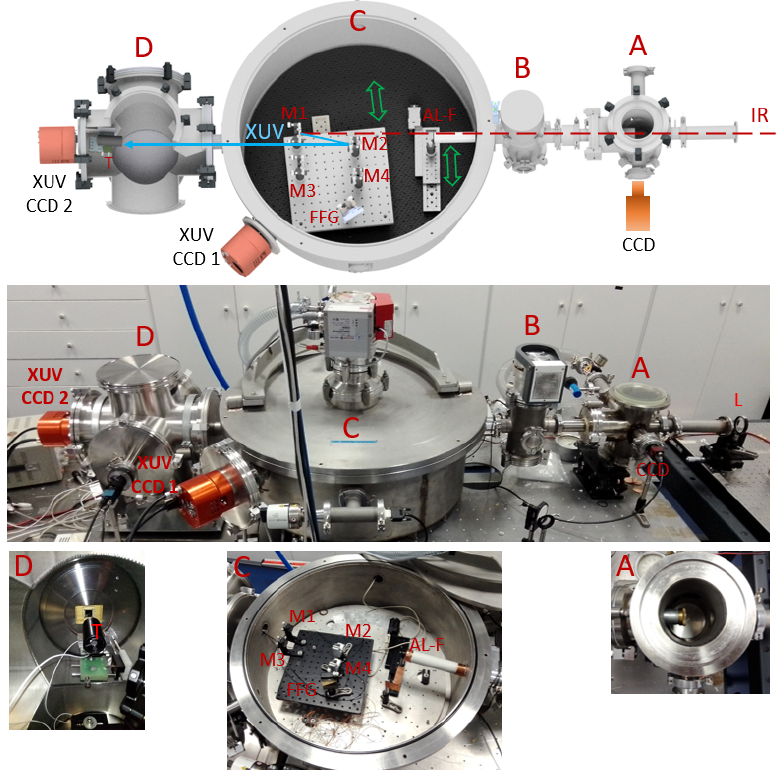
Figure 1. The XUV CDI experimental setup shown in a CAD design ( top ) and in the IPPL laboratory with zoom pictures for the stages of A, C, and D ( middle and bottom ). A: The first stage hosting the semi-infinite gas cell. B: The second stage hosting the differentially pumped region. C: The third stage hosting the XUV filtering, diagnostics, and wavelength selection. D: The fourth stage hosting the target and the recording of the CDI result. L: lens. AL-F: aluminum filter. M1, M3: flat multilayer mirrors. M2, M4: spherical concave multilayer mirrors. FFG: flat field grating. T: